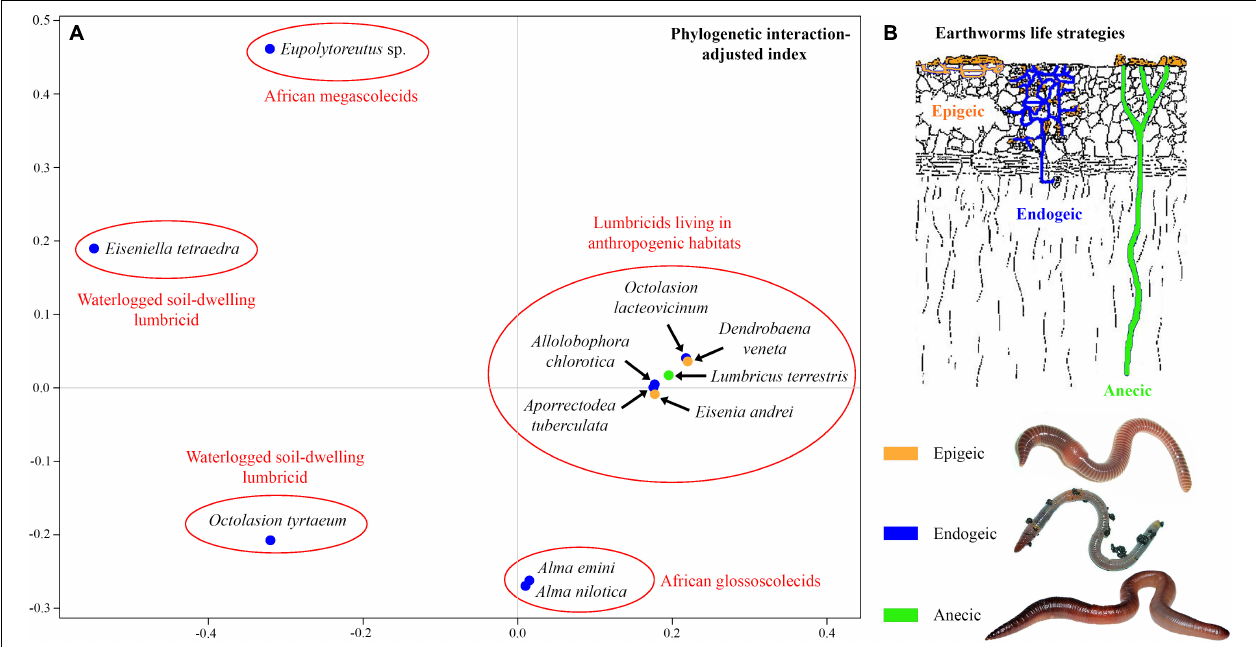
FIGURE 5 | (A) Metric multidimensional scaling plot of 11 earthworm species based on phylogenetic relationships of their astome endosymbionts. The similarity was measured with the unweighted phylogenetic interaction-adjusted (PINA) index. (B) Earthworm life strategies. Colors denote the individual ecological group of